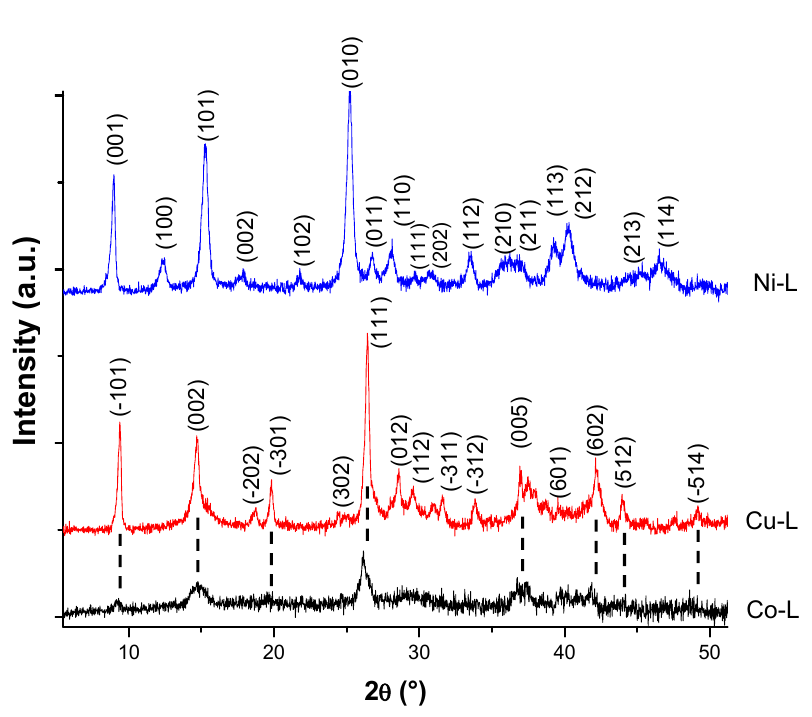
Figure 1. XRD patterns for Co, Cu and Ni CPs showing some of the hkl indices.